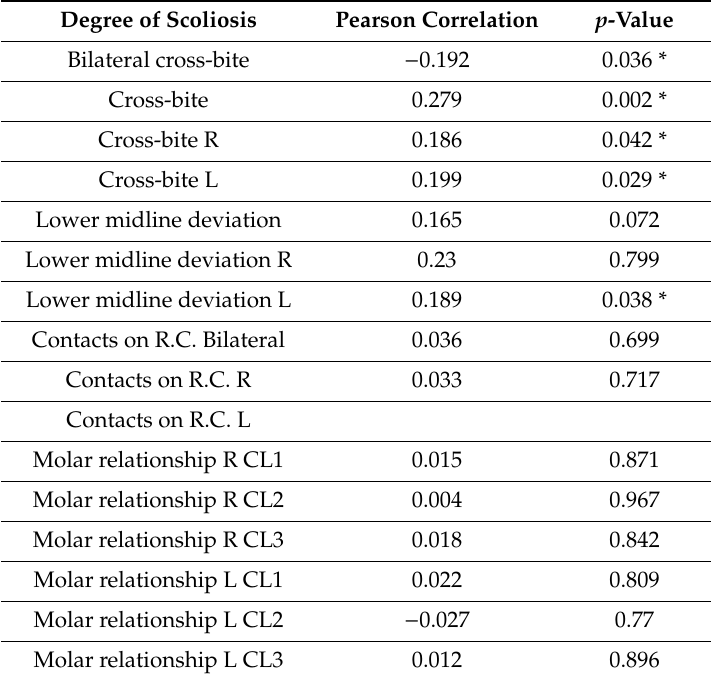
Table 6. Values of r Pearson correlation in our sample. *: p < 0.05, statistically significant. Degree of Scoliosis Pearson